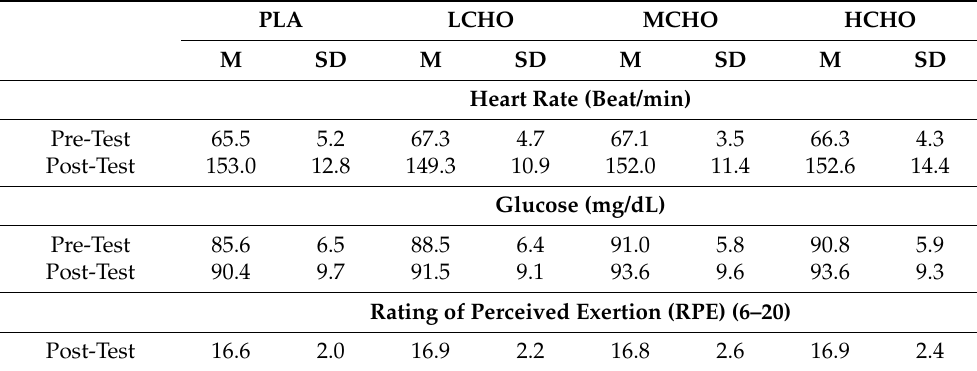
Figure 3. Muscular Endurance total repetitions ( A ) and total volume ( B ). Table 1. Heart rate, glucose and ratings of perceived exertion before and after the exercise protocol in each